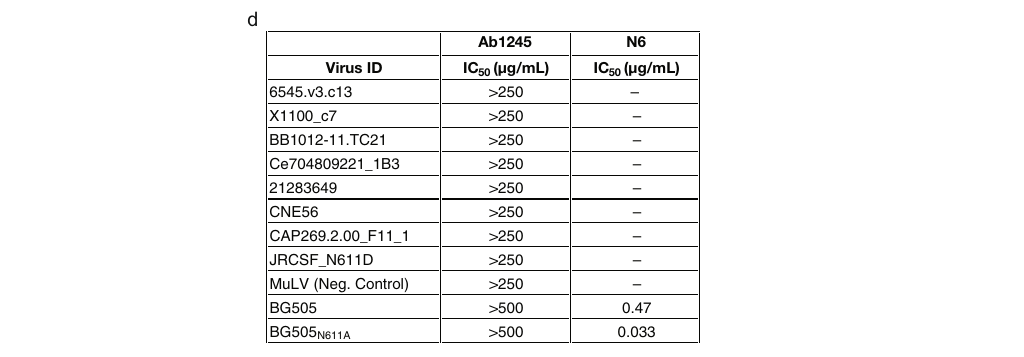
Fig. 4 Ab1245 CDRH3 mimics gp41 interactions with the tryptophan clasp. a Cartoon representation of the interactions between Ab1245 V H -V L domains (pink with CDRH3 in cyan) and the tryptophan clasp of gp41 (gp41 in dark gray with Trp residues 623 gp41 , 628 gp41 , and 631 gp41 in dark blue) with gp120 in light gray. Interacting residues between M100c HC and the tryptophan clasp shown as sticks. b Cartoon representation of the same view of an unbound protomer of gp41 with the portion of gp41 containing the fusion peptide (red) and fusion peptide proximal region (FPPR, green) interacting with the gp41 tryptophan clasp (same coloring as in ( a )). Interactions between M530